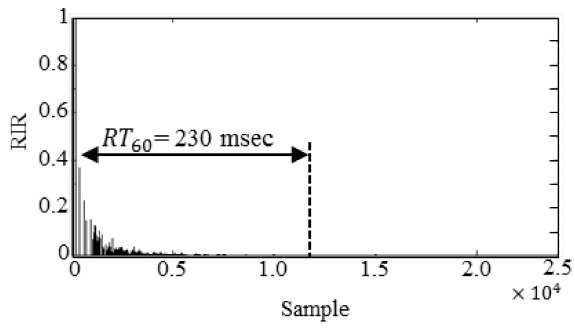
Figure 8. Simulated room impulse response of the left channel based on the image method, where RT 60 was measured as 230